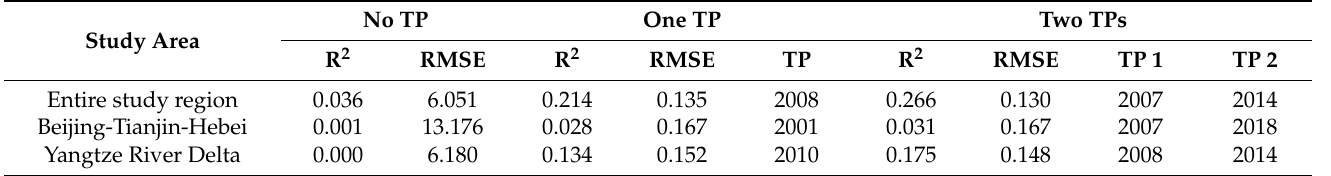
Table A1. The calculated R 2 and RMSE for the monthly population-weighted mean PM 2.5 time series in the study region and eight urban agglomerations under the conditions with no turning point, one turning point and two turning